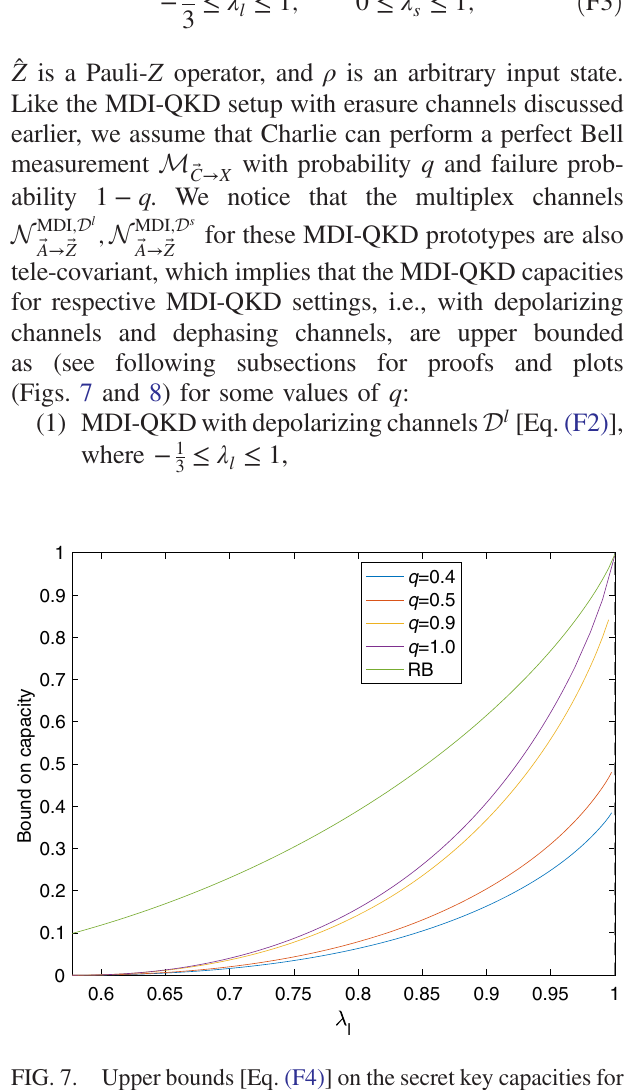
FIG. 7. Upper bounds [Eq. (F4)] on the secret key capacities for the MDI-QKD protocol with depolarizing channels for different values of parameters q and λ , in comparison to the RB l bound [48].